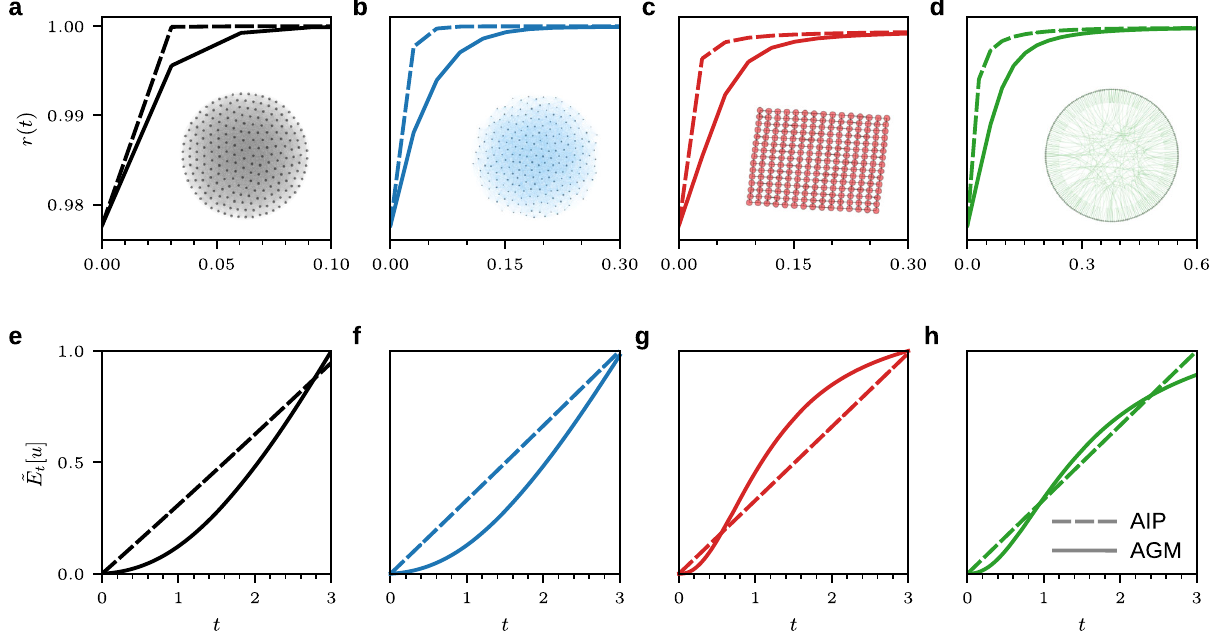
Fig. 4 Controlling coupled oscillators with AI Pontryagin and the AGM. We test the performance of AI Pontryagin and the AGM [Eqs. (17) and (18)] to control coupled Kuramoto oscillators [ a , e complete network (black lines), b , f Erd ő s – Rényi network G ( N , p ) with p = 0.3 (blue lines), c , g square lattice without periodic boundary conditions (red lines), and d , h Watts – Strogatz network with degree k ¼ 5 and a rewiring probability of 0 : 3 (green lines)]. All graphs have N ¼ 225 nodes and the total simulation time is T ¼ 3. Panels ( a – d ) show the order parameter r ð t Þ and panels ( e – h ) show the normalized control energy ~ E t ½ u (cid:3) ¼ E t ½ u (cid:3) = max ð E AIP t ½ u (cid:3) ; E AGM t ½ u (cid:3)Þ . The abbreviation AIP stands for AI Pontryagin. Dashed and solid lines indicate AI Pontryagin and AGM solutions,